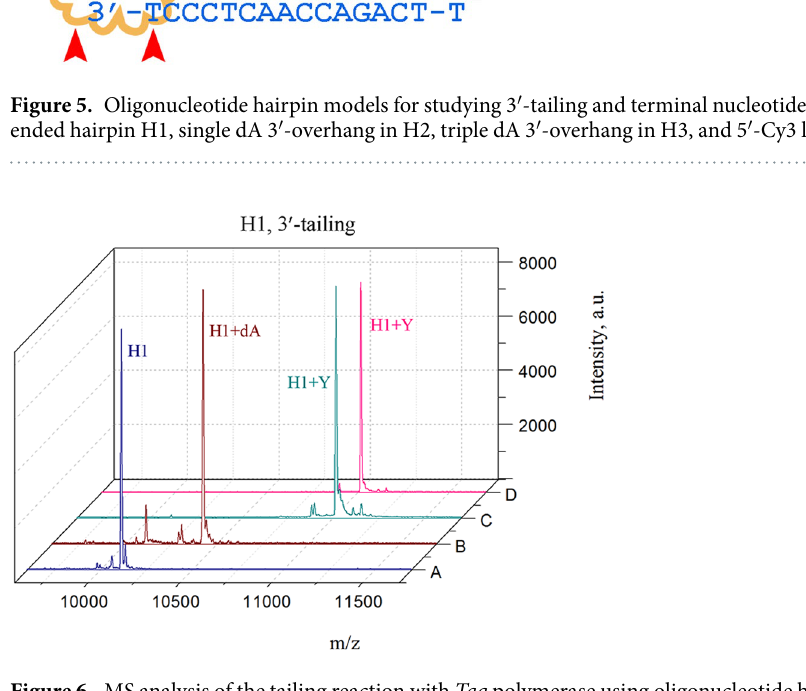
Figure 6. MS analysis of the tailing reaction with Taq polymerase using oligonucleotide hairpin H1. ( A ) Reference oligonucleotide H1. ( B ) Tailing reaction at 64 °C for 2 hours in the presence of 200 μ M natural dNTPs (dA, dG, and dC). ( C ) Tailing reaction in the presence of Y alone. ( D ) Exposure of H1 to Taq DNA polymerase in the presence of the nucleotide mixture dA, dG, dC, and Y. Non-natural nucleotide Y has been demonstrated to be a preferred substrate in the 3 ′ -tailing